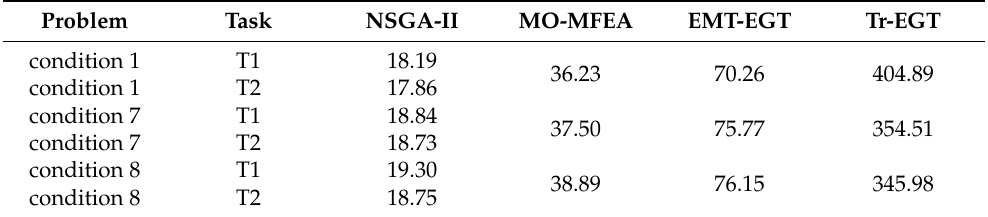
Table 8. Mean computational times obtained between different algorithms for Conditions 1, 7, 8 over 20 runs in task 1 and task 2 (in seconds).